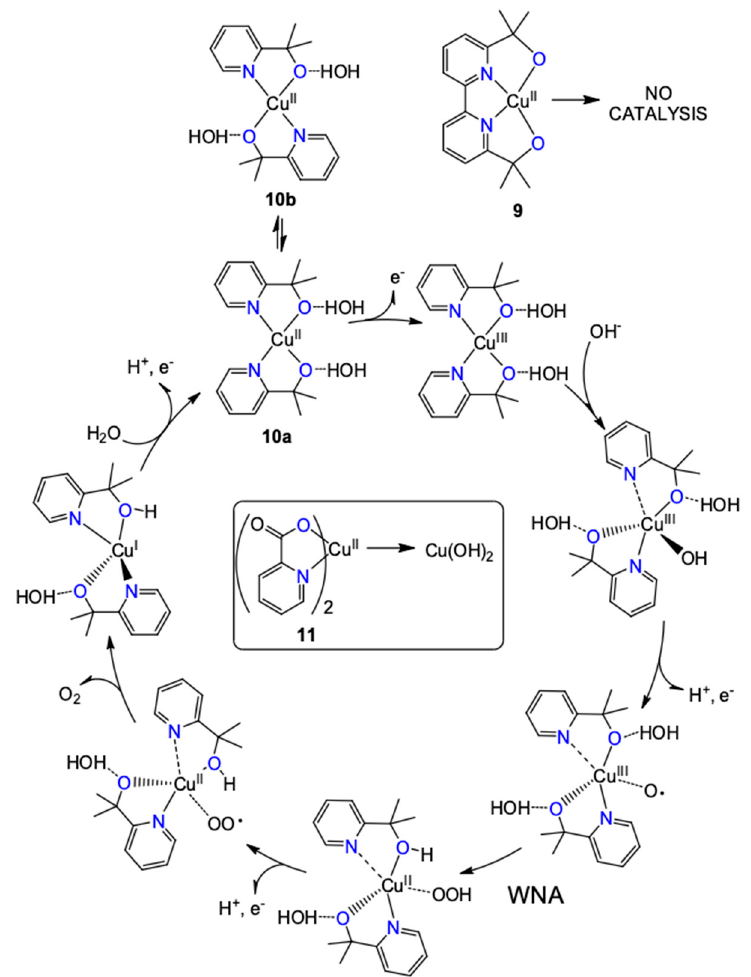
Figure 8. Steps of the water nucleophilic attack mechanism for 10 by density functional theory (DFT) and the behavior of the closely related 9 and 11 [47].